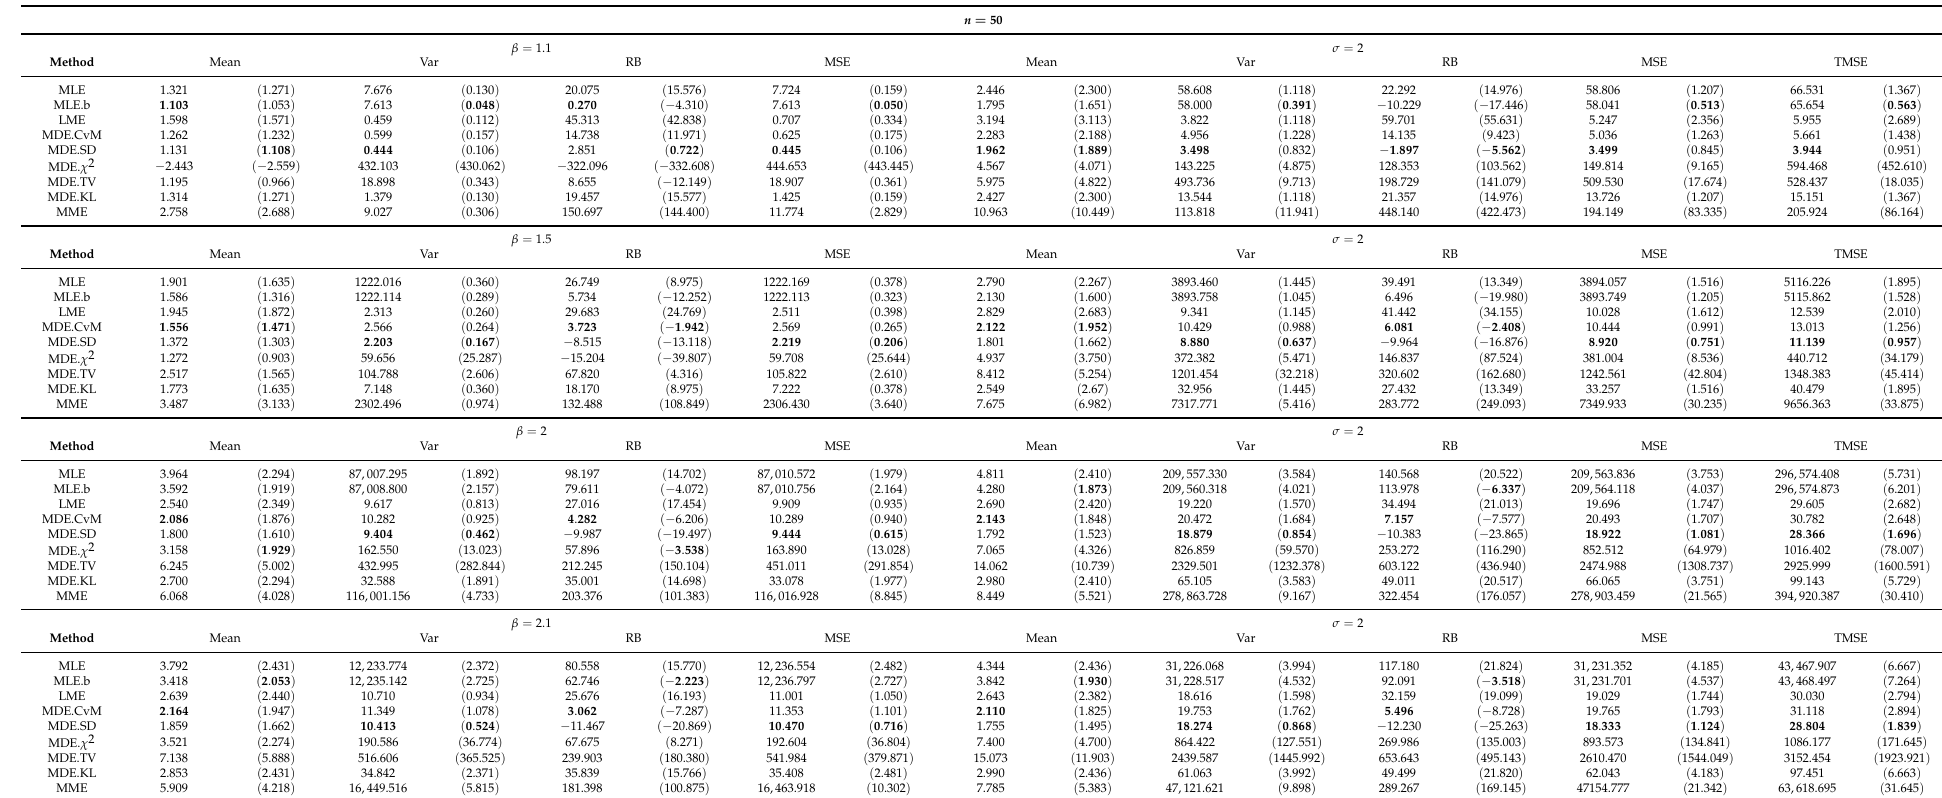
Table 4. Comparison of different estimation methods for different values of β ( σ = 2 and n =